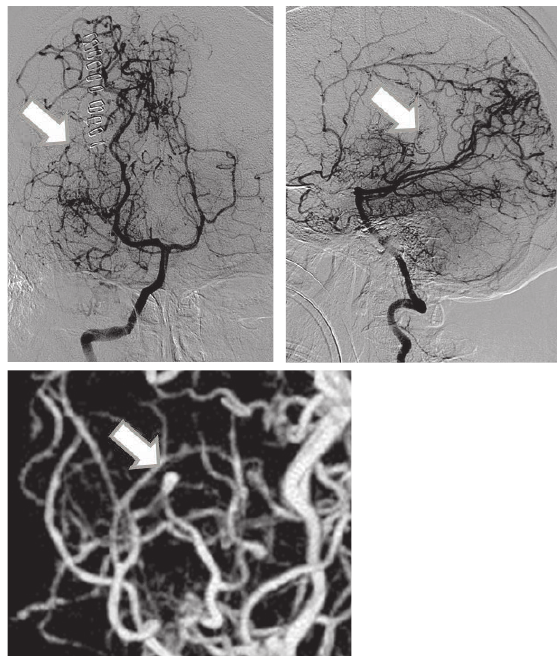
Figure 2. Right vertebral angiogram reveals the aneurysm on the right lateral posterior choroidal artery (arrow).